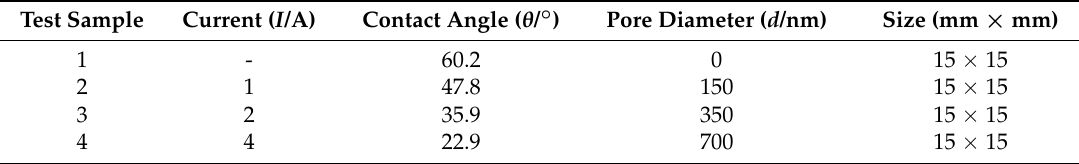
Table 1. The parameters of the experimental samples.